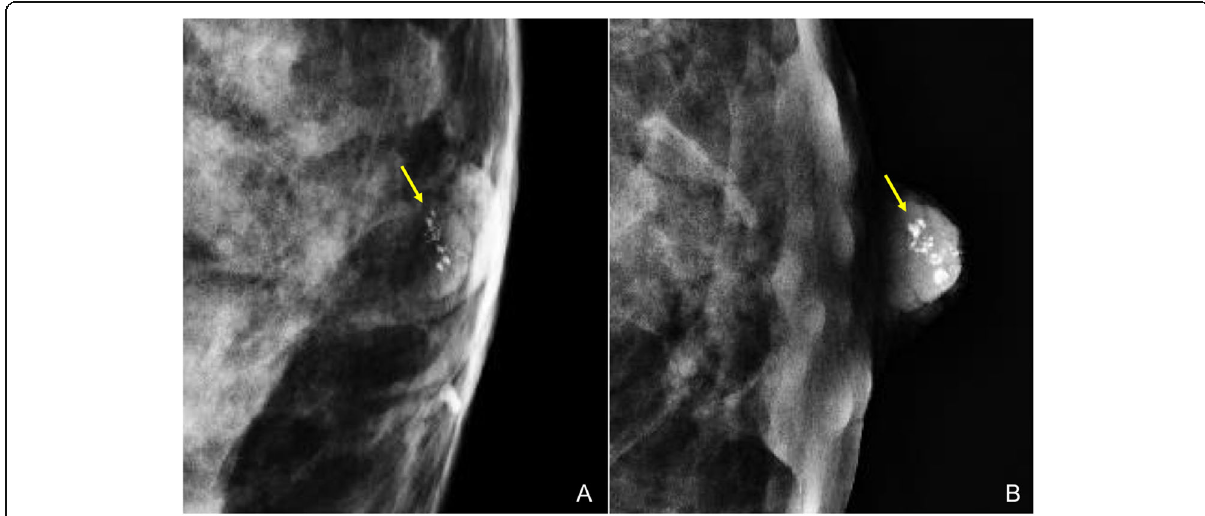
Fig. 9 Nipple calcifications. Screening mammogram in a 54-year-old woman. a Craniocaudal view of the left breast shows a group of